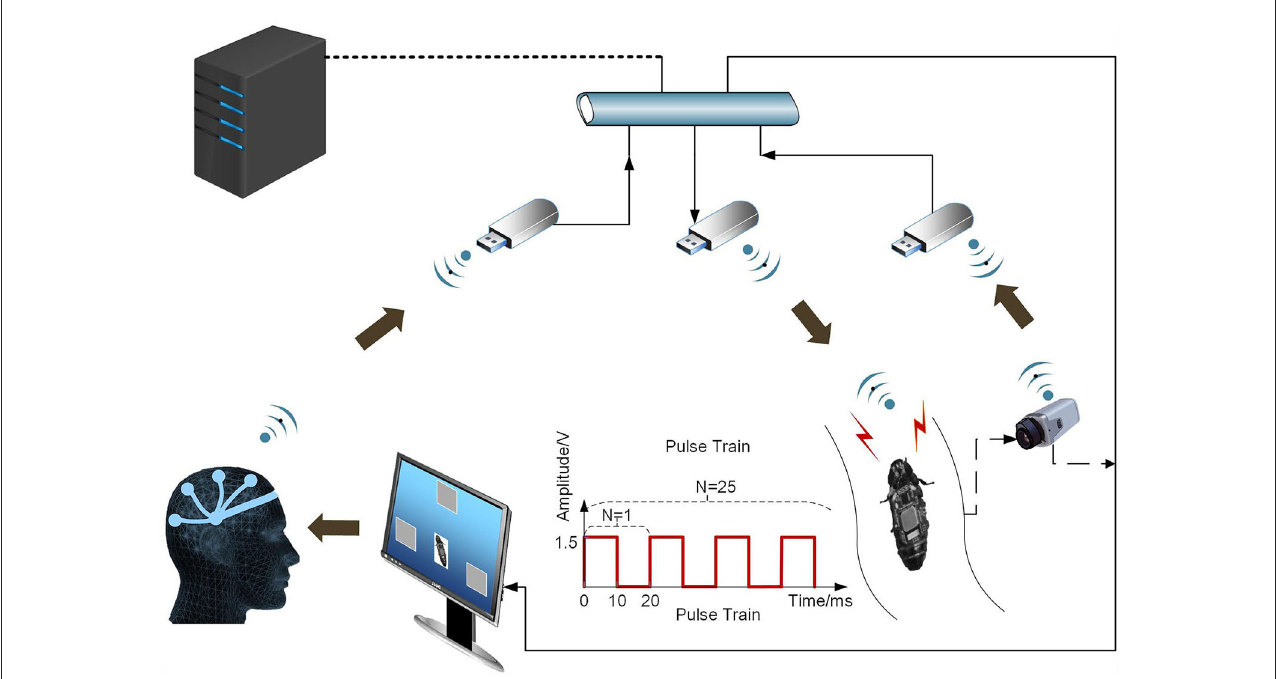
FIGURE1 The experimental system encompasses a person, a cockroach and a steady-state visual evoked potential (SSVEP) based brain-computer interface (BCI). The distributed system works as the subject sends real time BCI commands to the cockroach as a person responds to a flickering image of the cockroach. Link to original source: https://journals.plos.org/plosone/article?id=10.1371/journal.pone.0150667.